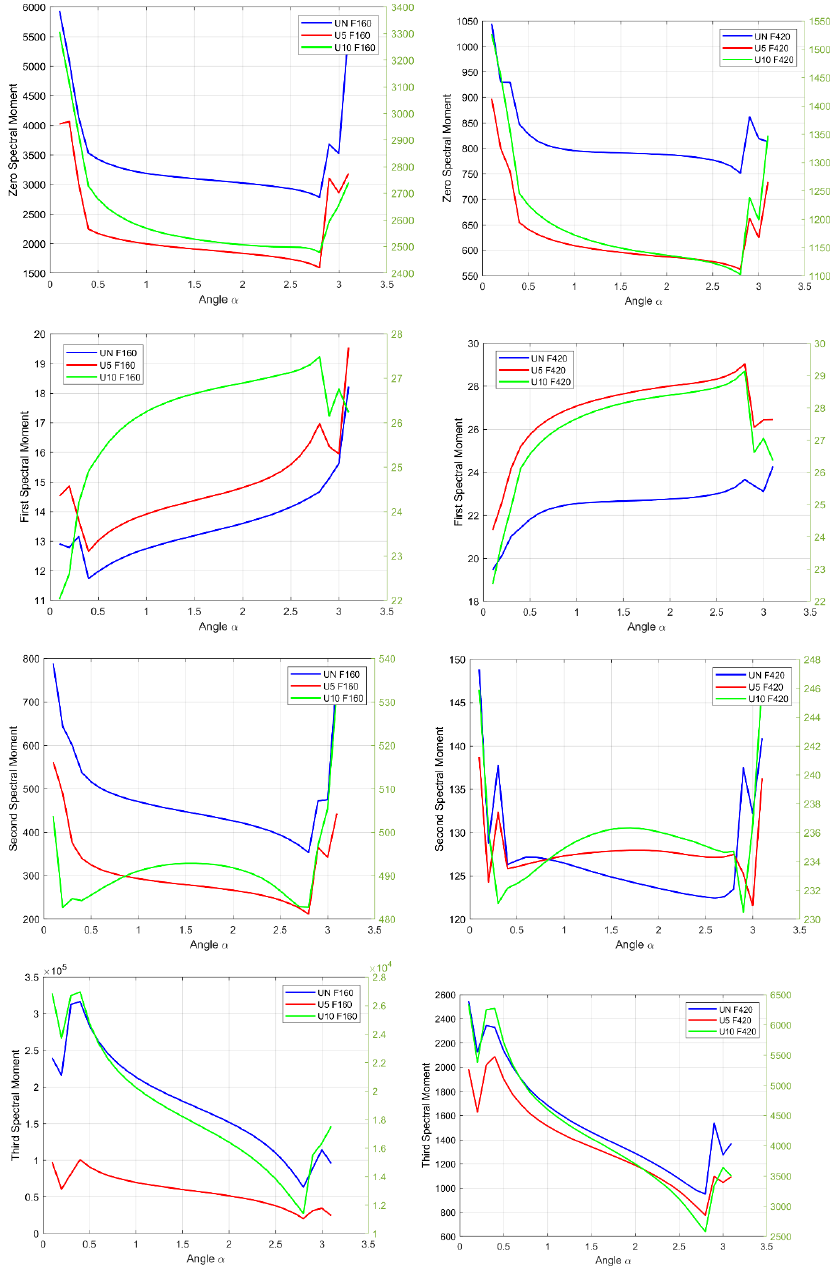
Figure 8. Spectral moments for the generalized Hilbert transform; the left axis indicates UN and U5, and the right axis indicates U10.